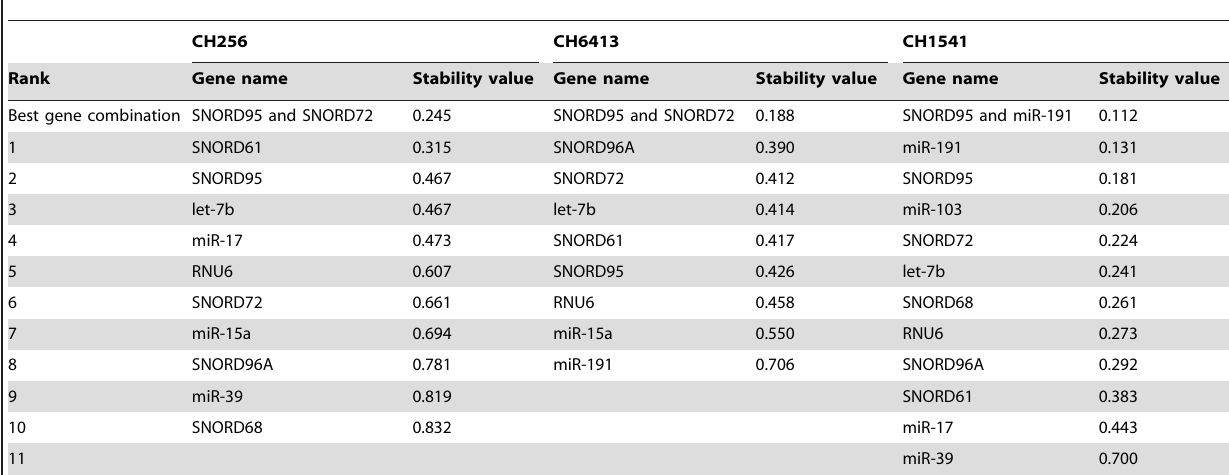
Table 1. Selection of the most stable endogenous control genes for miR-122 results normalization in HCV-inoculated chimpanzees